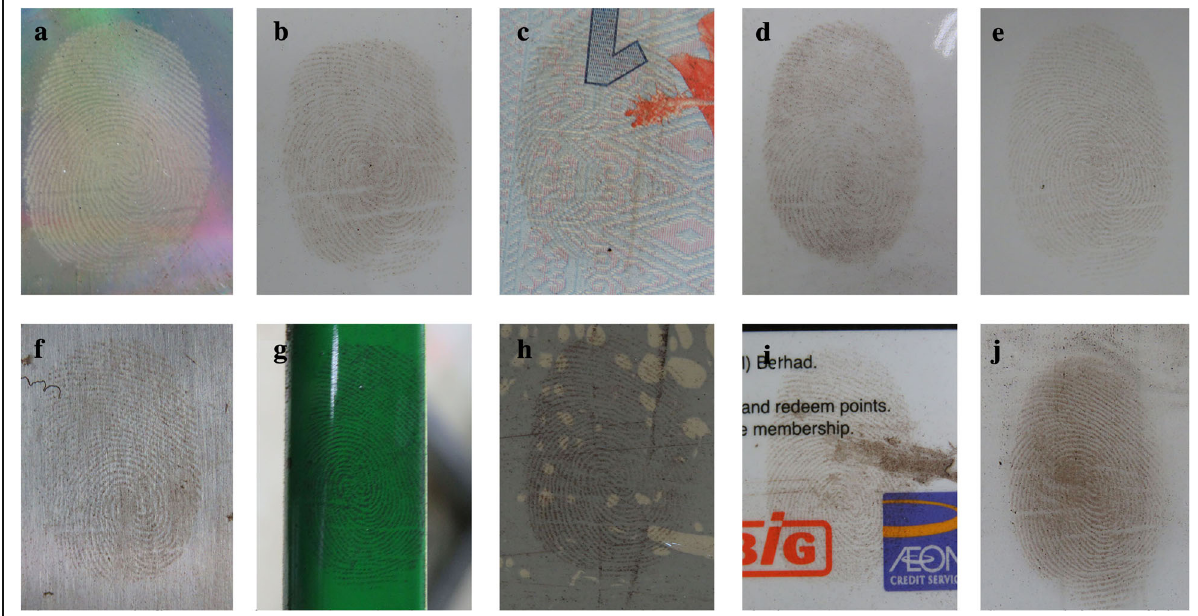
Fig. 5 Fresh fingermarks developed using NP on a CD-ROM, b tempered glass, c currency note, d porcelain crucible, e translucent plastic, f gloss painted wood, g stainless steel tool, h brown tape, i credit card and j electrical switch